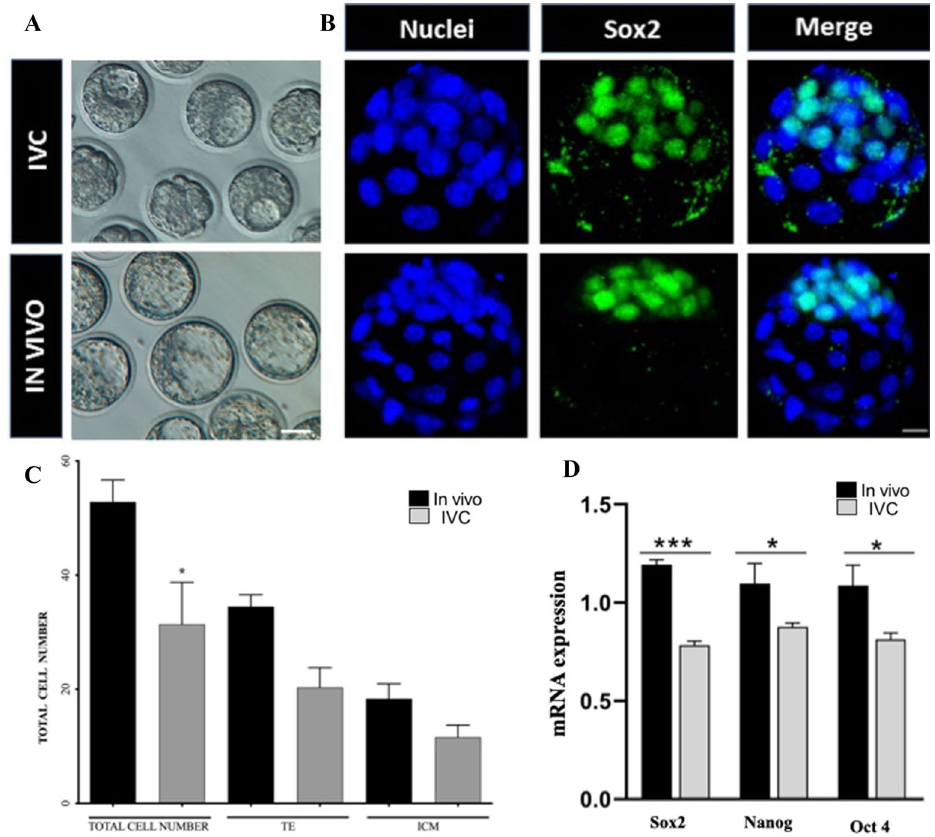
Figure 1. Representative image of IVC (upper line) and IN VIVO developed (bottom line) blastocysts at stage (E.3.5) in bright field (left) ( A ) and after staining with Sox2 [green; inner cell mass (ICM)] and Hoechst 33,342 (total cell number, nuclei) ( B ); ( C ) Graph represent total, ICM and trophoblast cell number in IVC and IN VIVO developed embryos at the blastocyst stage (E.3.5). Scale bars: 30 µm (bight field blastocyst) and 20 µm (immunoassayed blastocyst); *mean p < 0,05; ( D ) Sox2, Oct-4 and Nanog gene expression detected by qPCR in blastocysts stage embryos; Sox2 ***p < 0.0001, Nanog *p = 0.0217, Oct4 *p =